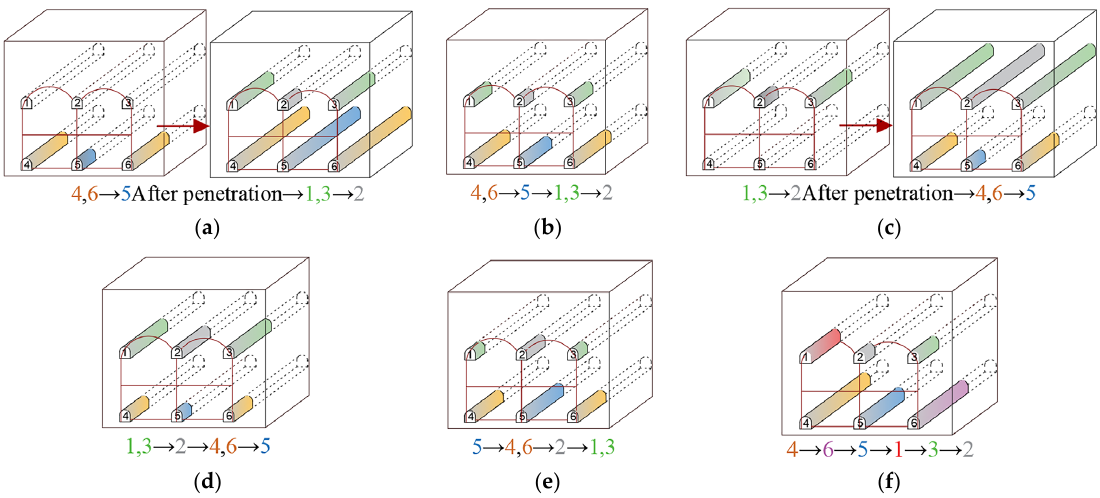
Figure 16. Diagram of six pilot tunnel excavation schemes: ( a ) plan 1; ( b ) plan 2; ( c ) plan 3; ( d ) plan 4; ( e ) plan 5; ( f ) plan 6.